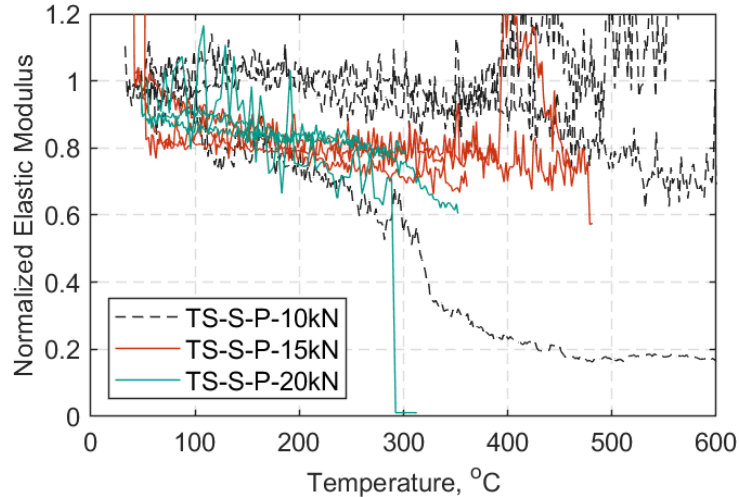
Figure A3. Normalized elastic modulus vs. temperature (°C), TS cases.